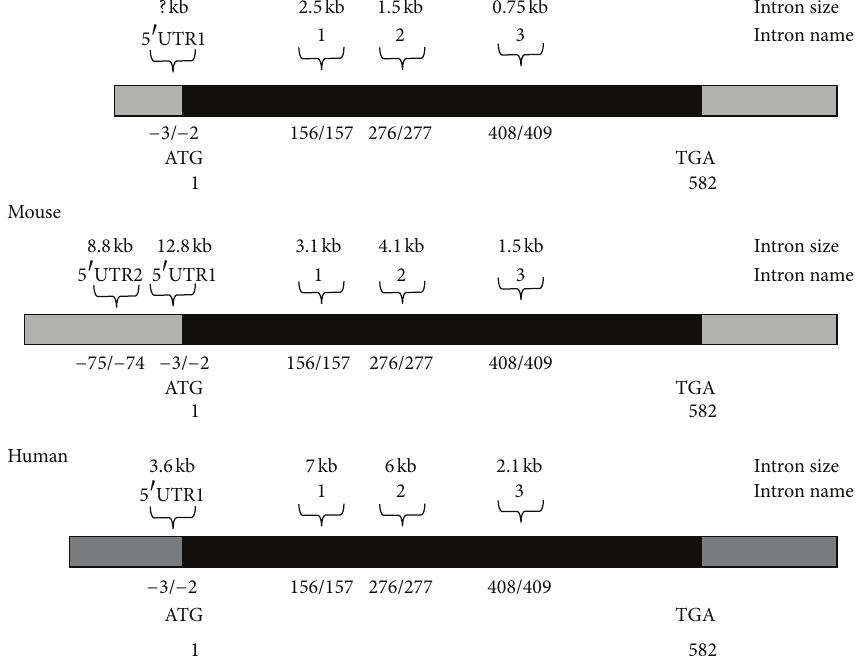
Figure 1: Comparative organisation of the chick, mouse, and human RhoA genes. Introns are indicated by their respective name and size above the cDNA line diagram and positioned as indicated by the nucleotide numbers below. Nucleotide position 1 refers to the A in the first in-frame ATG in the RhoA coding sequence. The open reading frame (ORF) is shown in black, with the start and stop codons and their respective nucleotide position shown below. The 5 󸀠 and 3 󸀠 untranslated regions (UTR) are depicted in